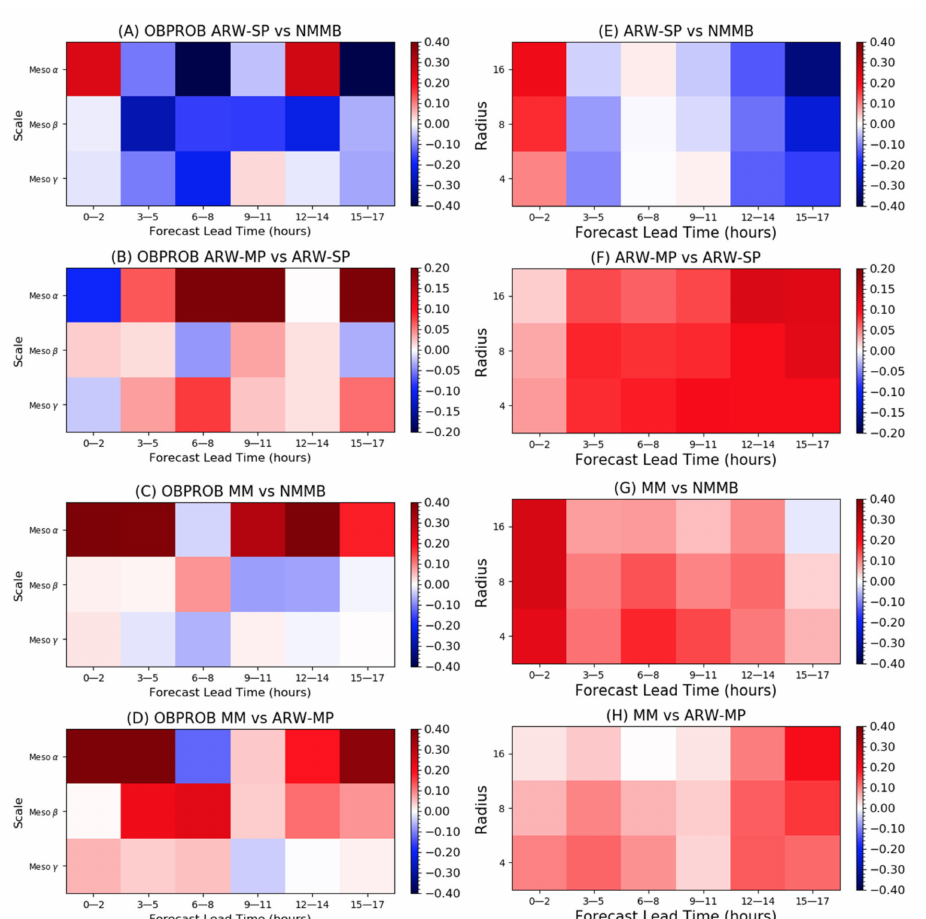
Figure 9. As in Figure 6, except for the 16 May 2015 case study. Statistical significance is not plotted due to data being representative of one case. Left column: Object-based Brier score averaged difference over all cases based on lead time and binned every three forecast hours for ( A ) SP vs. NMMB, ( C ) MP vs. SP, ( E ) MM vs. NMMB, and ( G ) MM vs. MP. Values shown are subtracted where red indicates added skill and blue indicates negative respective skill for the first ensemble listed in the title. Overlay p -value colors indicate the presence of statistical significance (green) at the 80% confidence level. Right column: Same as the left column except for neighborhood-based results for ( B ) SP vs. NMMB, ( D ) MP vs. SP, ( F ) MM vs. NMMB, and ( H ) MM vs. MP. Meso-alpha, beta, and gamma correspond to a radius of 16, 8, and 4,